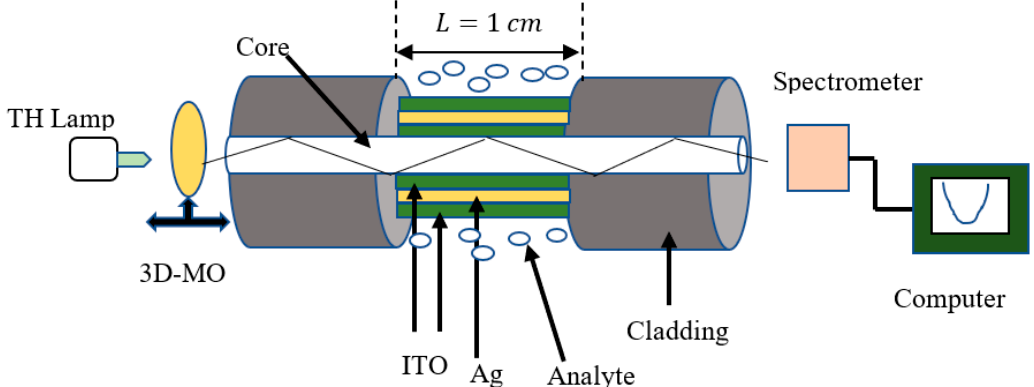
Figure 1. Schematic of the presented SPR setup (TH: tungsten halogen, 3D-MO: microscopic objective with 3D movement).